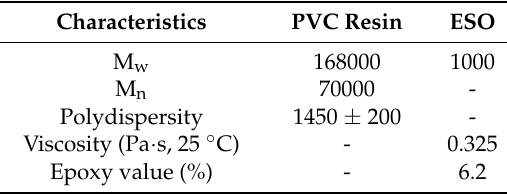
Table 2. Characteristics of PVC resin and